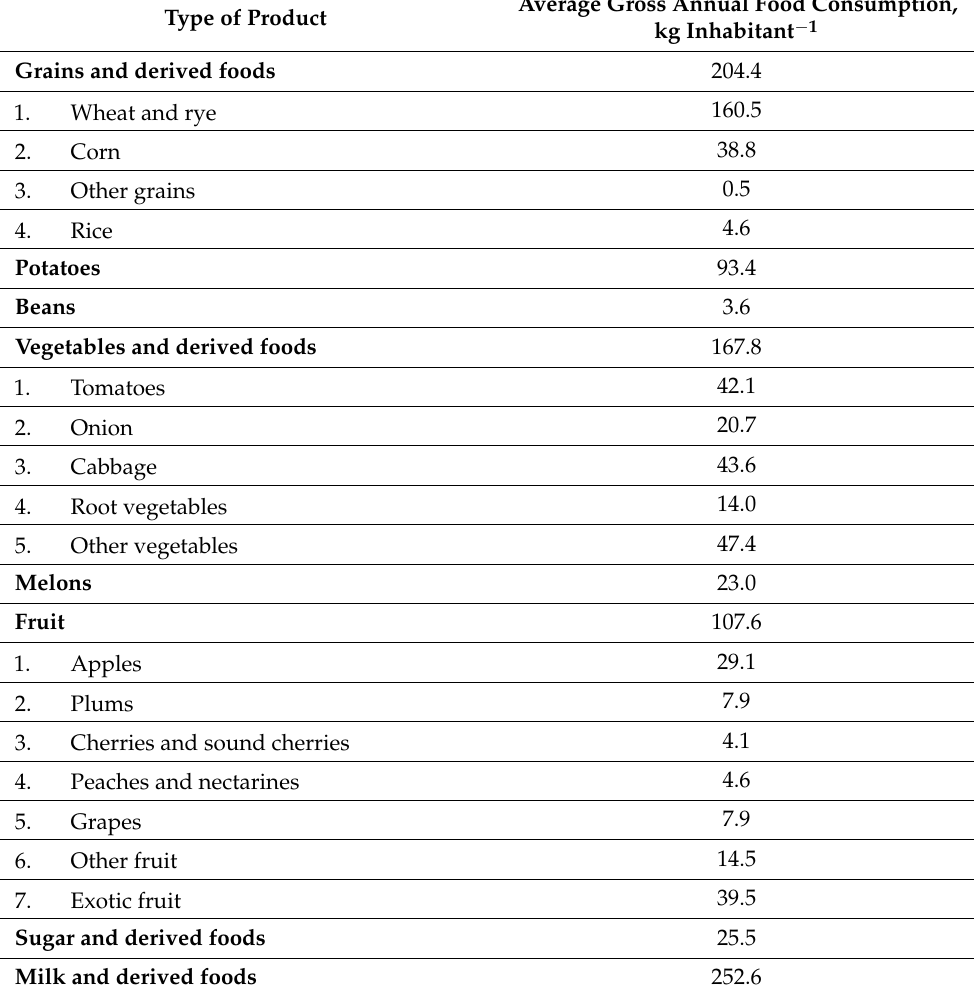
Table 1. Gross average annual consumption based on food